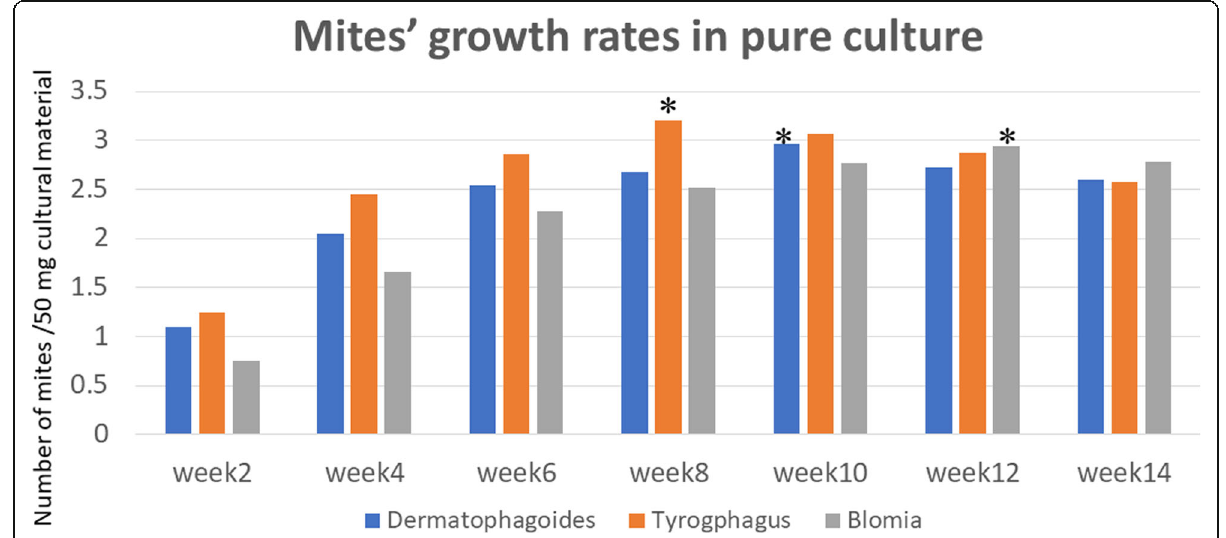
Fig. 3 Growth kinetics of Dermatophagoides, Tyrophagus, and Blomia spp. in 50-mg samples from their pure culture media (25 °C and 75% RH) along 14 weeks. Data represented as the log counts and average of 4 duplicates. *Peak growth